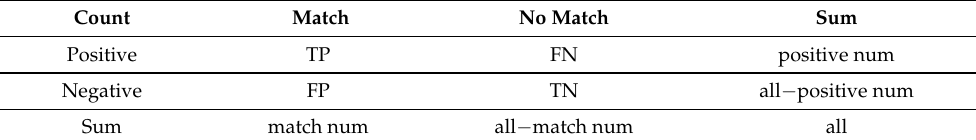
Table 4. Match and